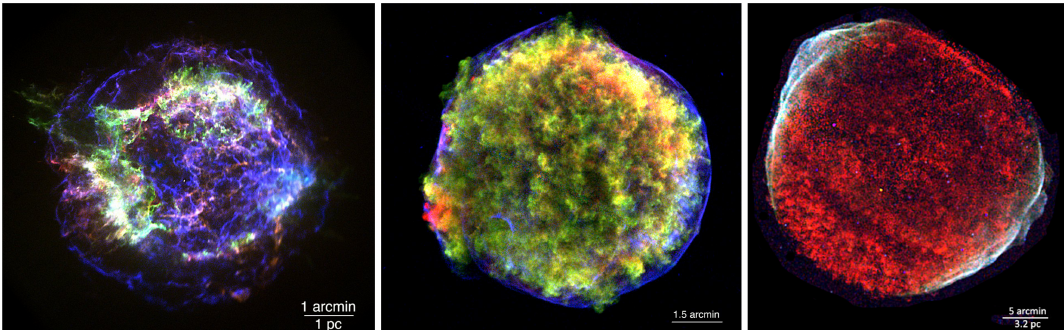
Figure 4. X-ray images of SNRs as observed by Chandra. In all cases the bluish colors represent X-ray synchrotron dominated emission, which in principle should be polarised. ( Left ) Cassiopeia A as observed in 2004. Red represents Mg XII and Fe L line emission, green Si XIII emission (around 1.85 keV), and blue is the 4–6 keV continuum band. ( Middle ) Tycho’s SNR, blue is the 4–6 keV band, green is Si XIII (1.75–1.95 keV)and red is Fe L emission (0.8–0.95 keV). ( Right ) SN1006, red is the 0.5–0.65 keV band, dominated by O VII oxygen emission, green is 0.85–2.0 keV, dominated by line emission from Ne IX, Mg XI and Si XIII (and lower ionisation states), and blue is 3–6.3 keV, dominated by synchrotron